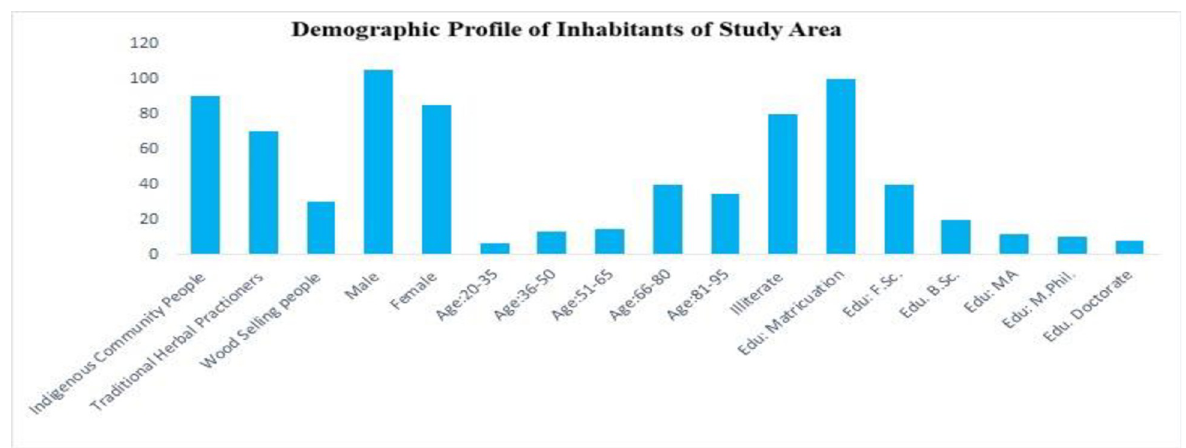
Fig 2. Demographic information of Study area Shiwalik mountaineous range of District Bhimber of AJK.